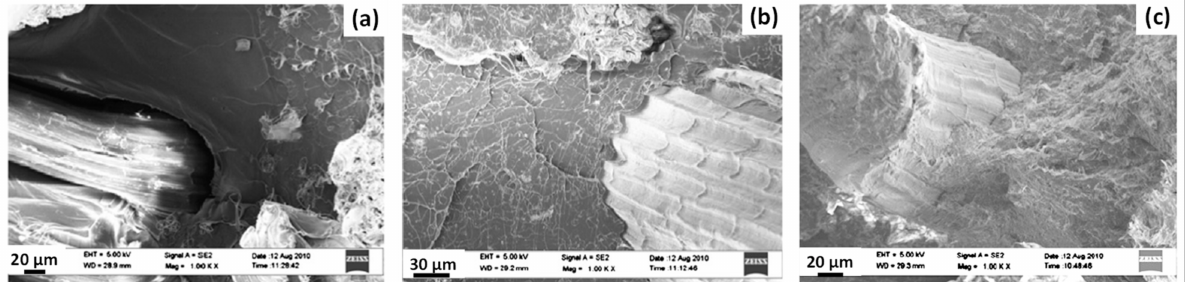
Figure 19. Fractured surfaces of hierarchical BC/sisal fibres reinforced PLA biocomposites, ( a ) untreated sisal fibres, ( b ) “hairy” BC-coated sisal fibres and ( c ) “hairy” BC-coated sisal fibres with BC dispersed in PLA matrix (reprinted with permission from Lee et al., 2012 [86]).